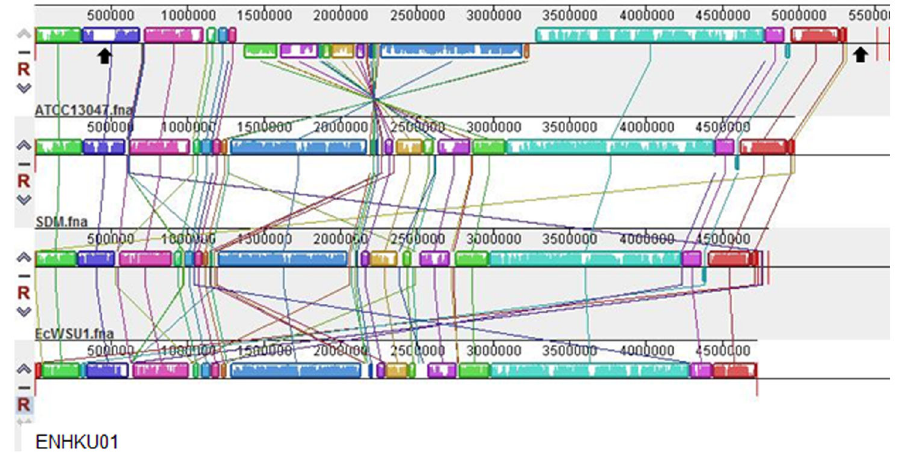
Figure 2. Genomic alignment of Enterobacter cloacae . MAUVE [35] alignment of the genome sequences of E. cloacae subsp. cloacae ATCC13047, E. cloacae subsp. dissolvens SDM, E. cloacae EcWSU1 and E. cloacae subsp. cloacae ENHKU01. Same color boxes represent homologous regions of sequence, without rearrangement (locally collinear blocks or LCB), shared between E. cloacae genomes. Black arrows show the genomic position of the T4SS located in ATCC13047. doi: